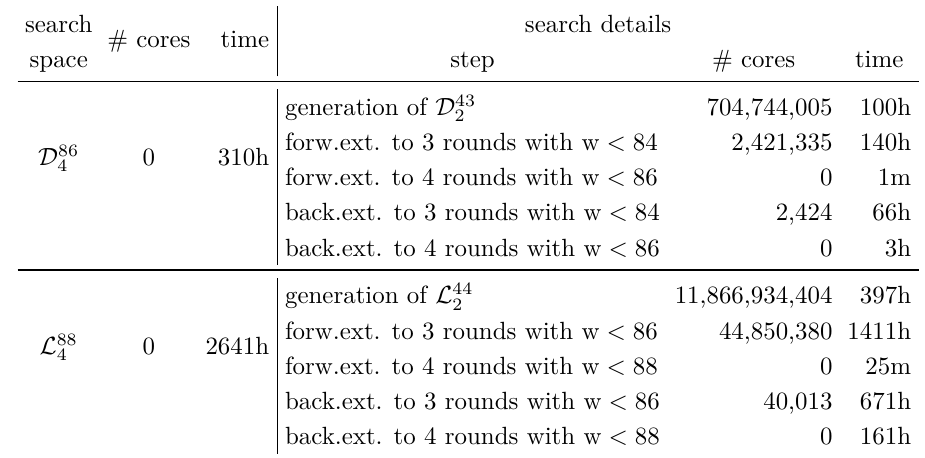
Table 4: Details on the generation of canonical 4-round differential and linear trail cores with weight lower than 86 and 88, respectively. Timings are rounded to the closest